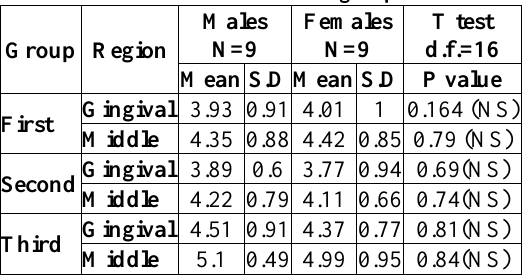
Table 2: descriptive statistics and gender difference for the ∆ E within each group.